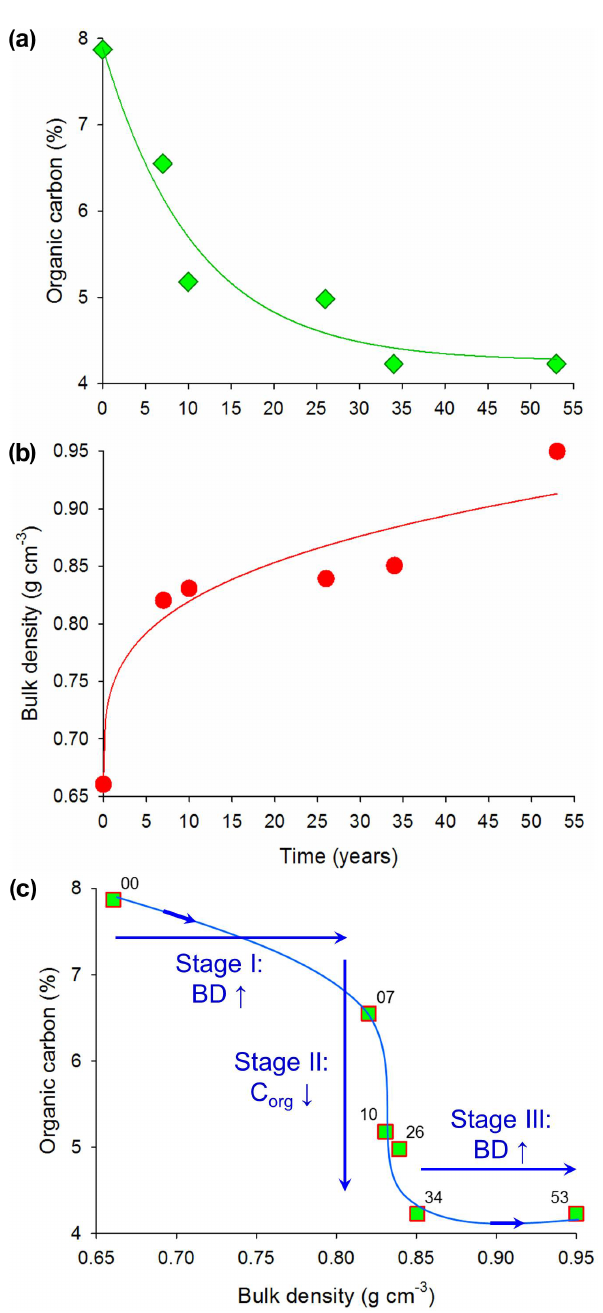
Figure 6. Effects of duration of forest conversion to cropland on decreasing soil organic carbon (SOC) (a) and increasing bulk den- sity (b) over 53 years (southern Ethiopian Highlands; Lemenih et al., 2005). (c) Phase diagram: relation between SOC and bulk density at corresponding time. Note the stepwise changes in bulk density following decreasing SOC content below the thresholds of 7.8%, 6.5% and 4.2%. Numbers beside symbols refer to years after